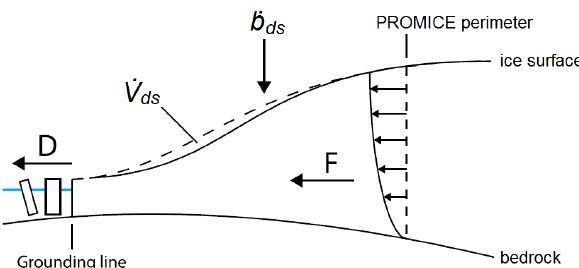
Fig. 2. Schematic representation of calculating ice discharge using the PROMICE perimeter. Ice discharge ( D ) at the grounding line is derived from downstream rate of change in ice volume ( V . ds ) and surface mass balance ( b . ds ) corrections applied to the ice flux ( F ) observed through the PROMICE perimeter (Andersen et al .